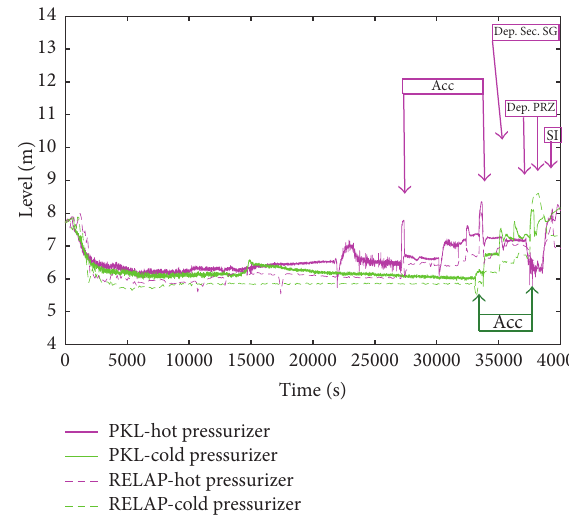
Figure 10: Vessel level PKL versus RELAP5. Temperature influence (Phase